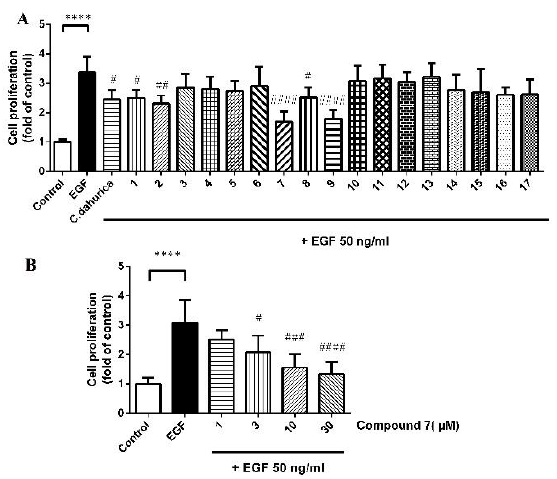
Figure 2. Proliferation of MCF-7 cells exposed to the extraction of Cimicifuga dahurica Maxim. at the concentration of 30 µg/mL or 10 µM of purified compounds ( 1 – 17 ) ( A ) and the increasing doses of compound 7 under simultaneous application of 50 mg/mL EGF ( B ). Means ± SD, n = 5 of three independent experiments: **** p < 0.0001 for the EGF group versus the control group; # p < 0.05, ## p < 0.01, ### p < 0.001, #### p < 0.0001 versus the EGF group.